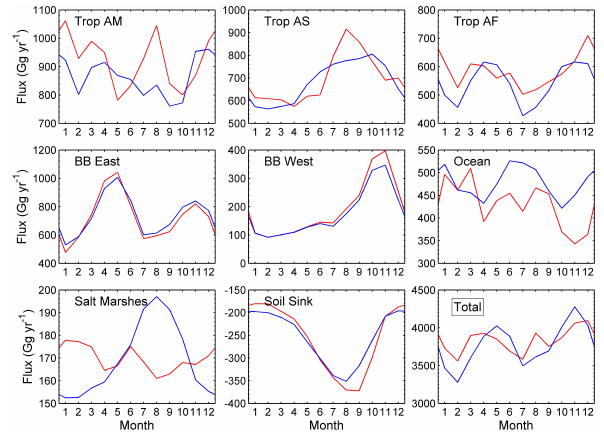
Fig. 9. The corresponding uncertainties (1 σ error bars) of the inver- sion results in Fig. 8, with the optimized error bars (red) superim- posed upon the reference error bars (blue).